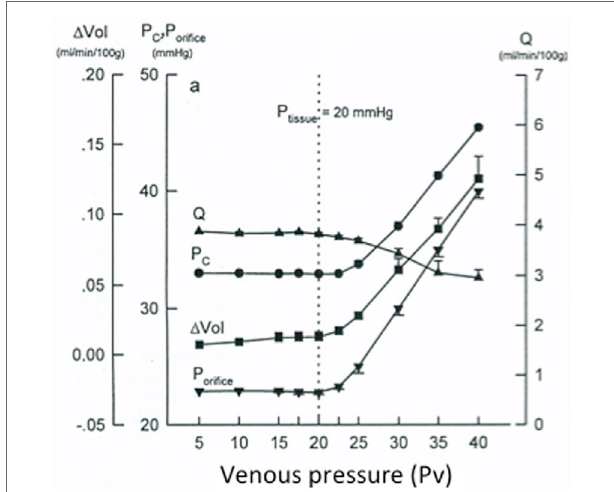
FiGURe 3 | Hemodynamic effects of an organ (skeletal muscle) enclosed in a rigid shell (plethysmograph) with a tissue pressure of 20 mmHg of variation in venous pressure just outside the shell ( P V ). The experiment was intended to simulate the attention: hemodynamic effects of extradural P V variations in the brain enclosed in the dura/cranium. The figure shows effects of change in P V on hydrostatic capillary pressure ( P c), on venous pressure just upstream of the venous collapse ( P orifice = P out in Figure 2 ), on change in tissue volume ( Δ Vol), and on blood flow (Q). Note that there are no hemodynamic effects of change in P V if P V is below the tissue pressure. If P V is above tissue pressure, there is no protective venous collapse (no R out , Figure 2 ), and the variations in P V are transferred in retrograde manner to the skeletal muscle. Reproduced from Ref. (30), with